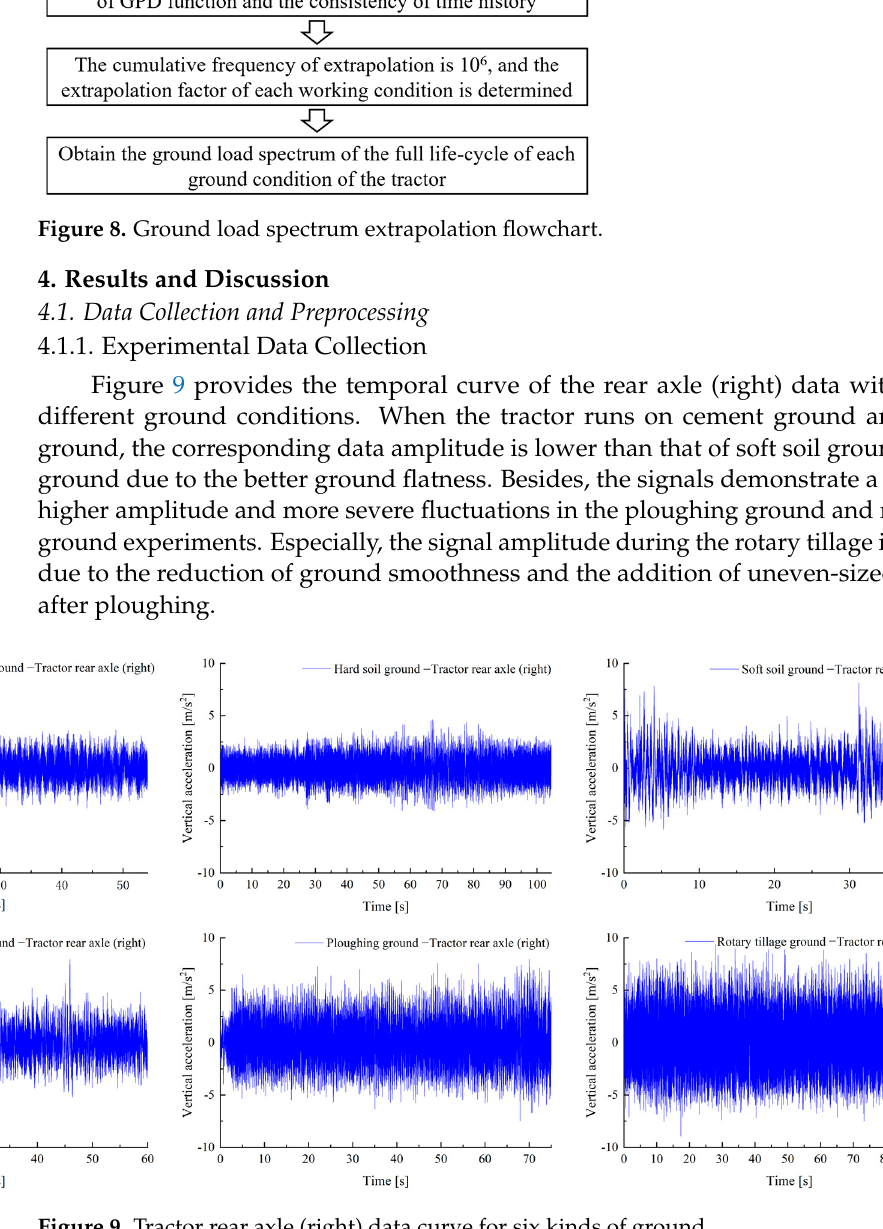
Figure 9. Tractor rear axle (right) data curve for six kinds of ground.